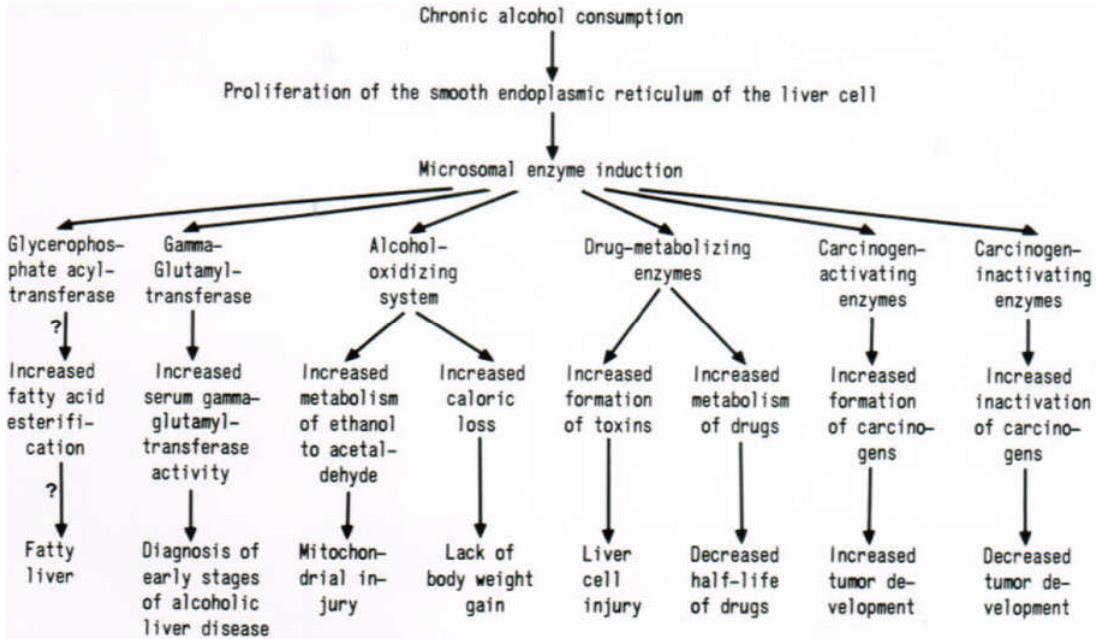
Figure 13. Proliferation of the smooth endoplasmic reticulum associated with microsomal induction of gamma‐glutamyltransferase (GGT) due to alcohol abuse. Chronic alcohol consumption induces also various other microsomal functions, which are of potential clinical relevance. In addition, increased GGT activities of the plasma membranes may contribute to increases in the serum [296,297]. Symbol: ?, under discussion. The original figure was published in an earlier report [23] and is reproduced with the permission of the Publisher Wiley (Hoboken, NJ, USA).